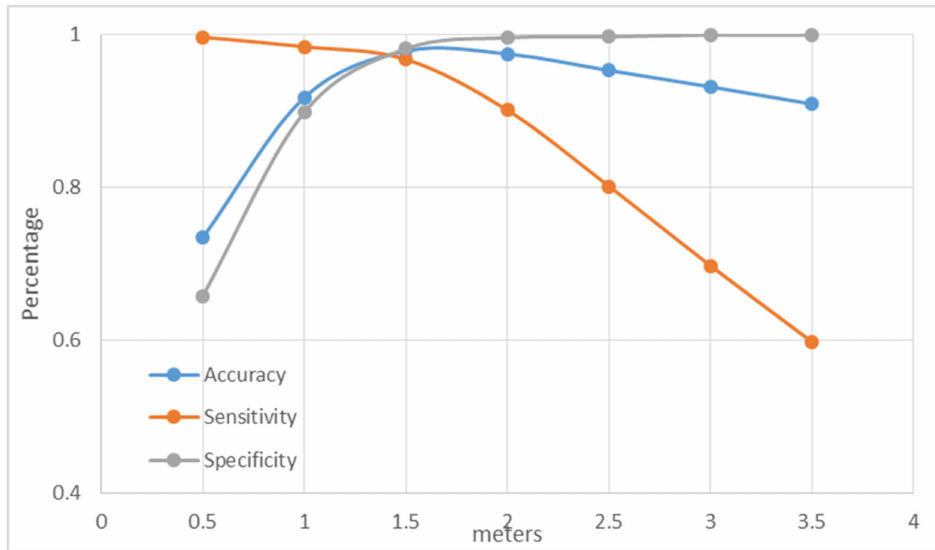
Figure 11. Accuracy, sensitivity and specificity for various thresholds—1.5 m of the mean height di ff erence between the two acquisition dates provided the highest accuracy and Kappa coe ffi